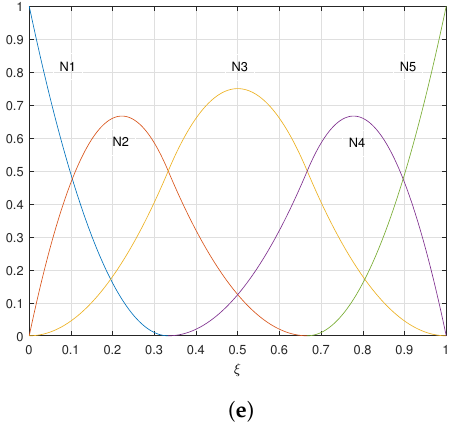
Figure 2. Shape functions, p = 5 , ( a ) Lagrange polynomials based on an equidistant nodal distri- bution, ( b ) Lagrange polynomials based on a GLL nodal distribution, ( c ) Lagrange polynomials based on a GLC nodal distribution, ( d ) p -FEM, and ( e ) IGA—the graphical representation of the basis functions related to the knot vector in Equation